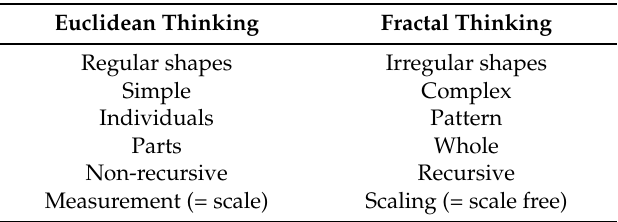
Table 1. Comparison of Euclidean and fractal